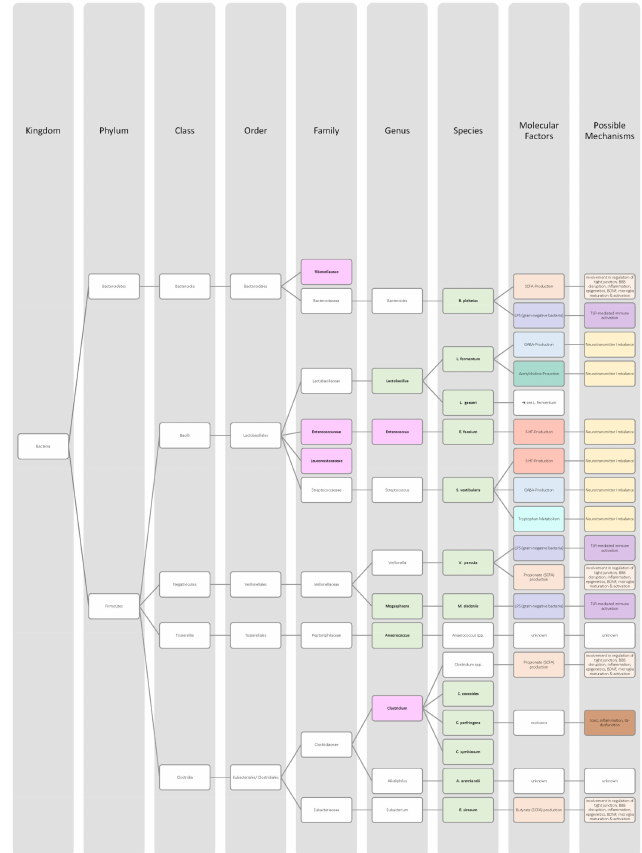
Figure 5. Part 1 of visual representation of the changes in microbiota composition in schizophrenia patients from Table 4. For an explanation, see the legend of Part 2 in Figure